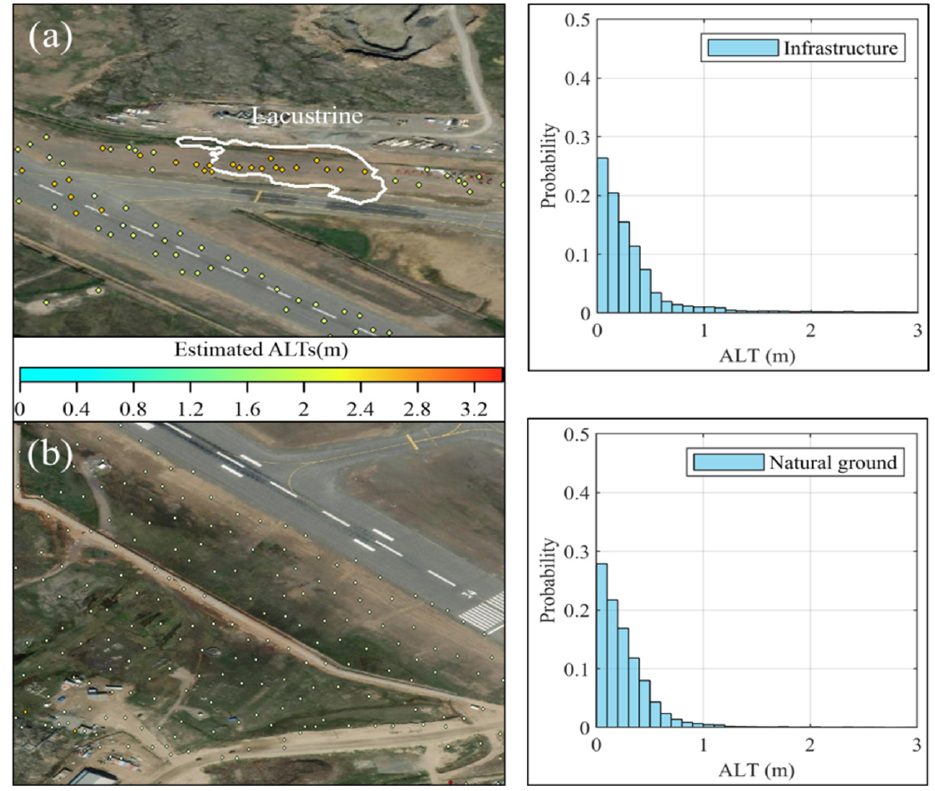
Figure 10. ( a ) Enlarged view and the statistic histogram of ALTs under infrastructure; ( b ) enlarged view and the statistic histogram of ALTs under natural ground.